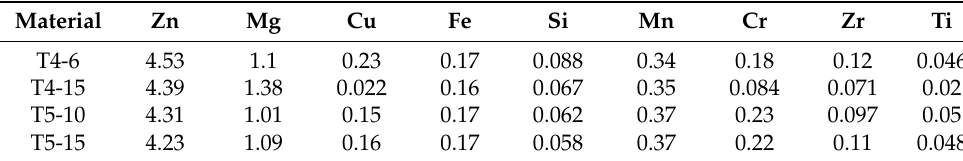
Table 1. Chemical composition of four aluminum alloys